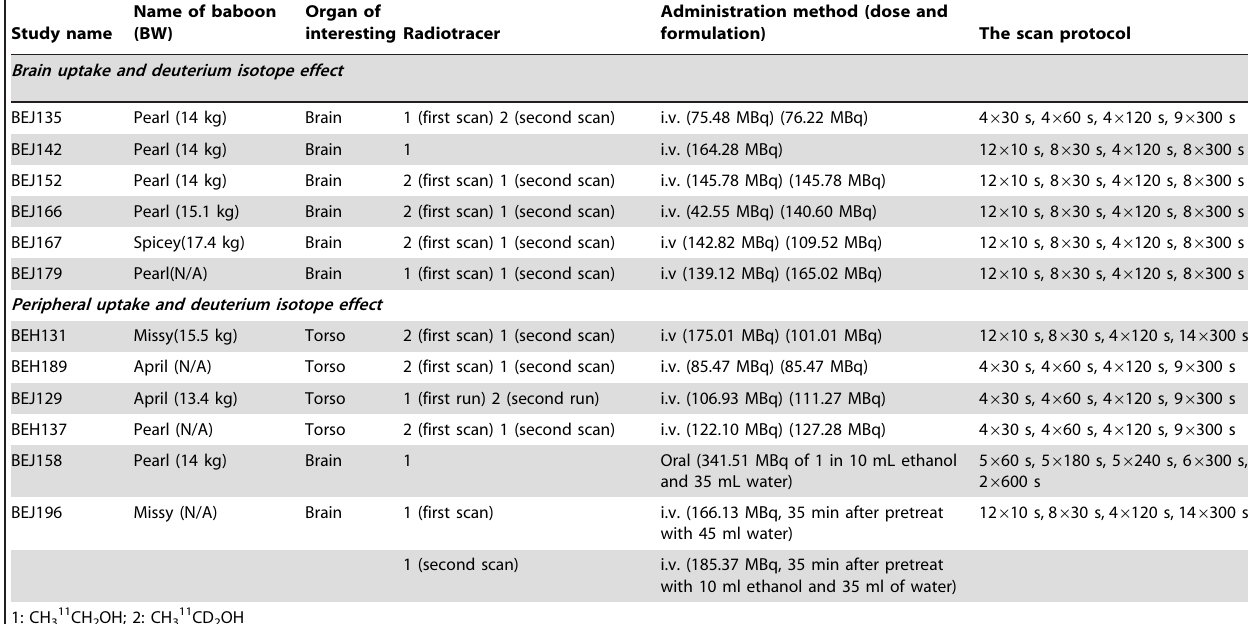
Table 1. Summary of Baboon PET studies.